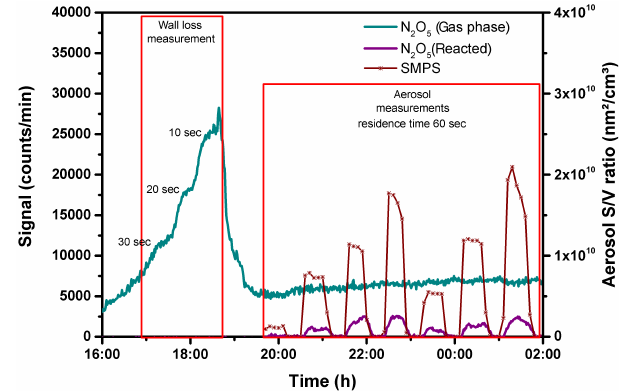
Figure 3. Uptake coefficient of N 2 O 5 on citric acid as a function of RH. Error bars represent 95% confidence bounds. The measured values can be found in Table S1 of the